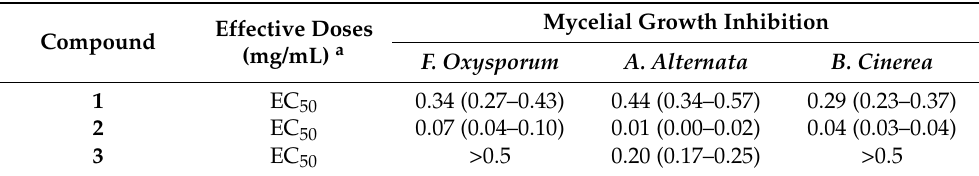
Table 3. Antifungal effects (mycelial growth inhibition) of compounds 1 – 3